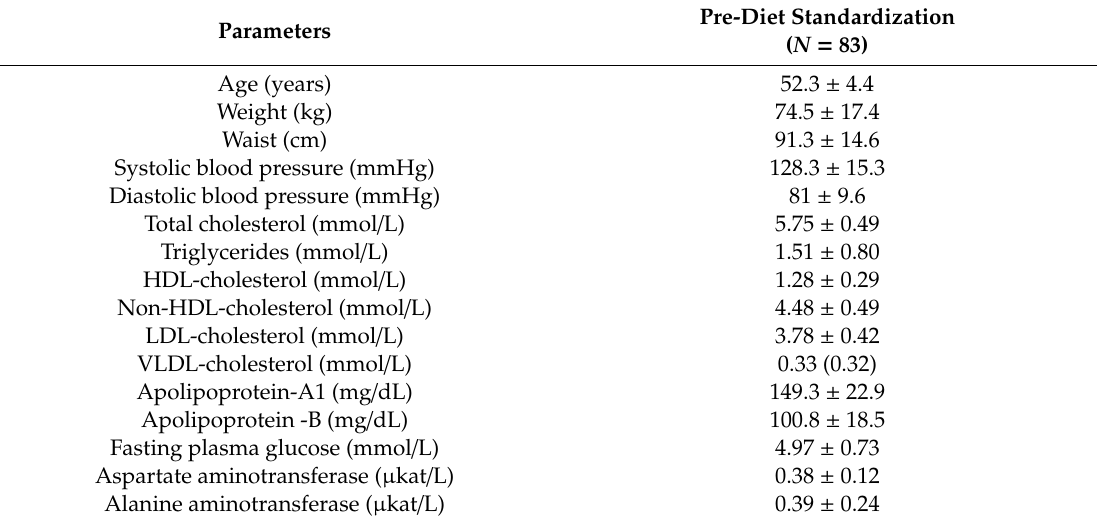
Table 2. Pre-diet standardization parameters, expressed as mean ± SD.